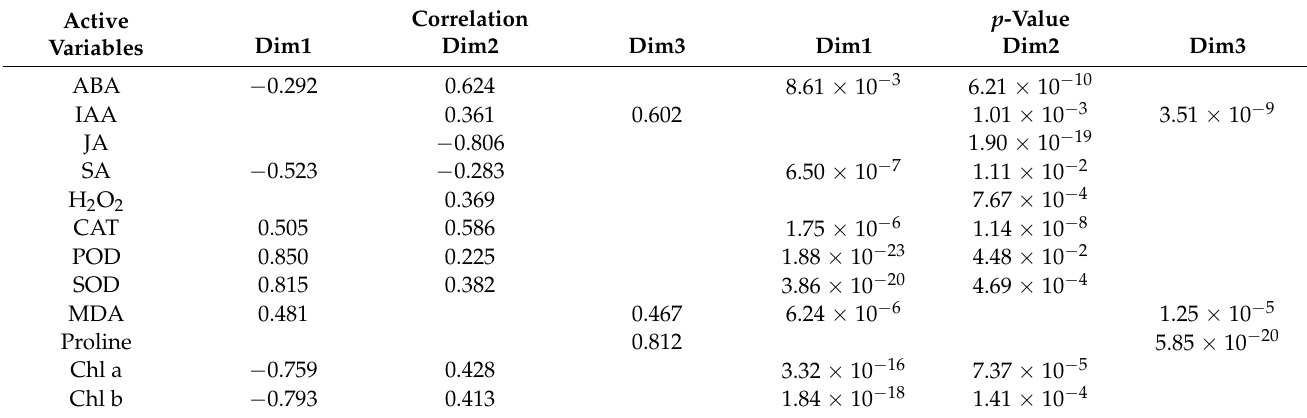
Table 3. Significant correlation coefficients of the active variables in the principal component analysis (PCA). The correlation coefficients describe the construction of the different dimensions of the PCA. For each significant coefficient, the p -value is also